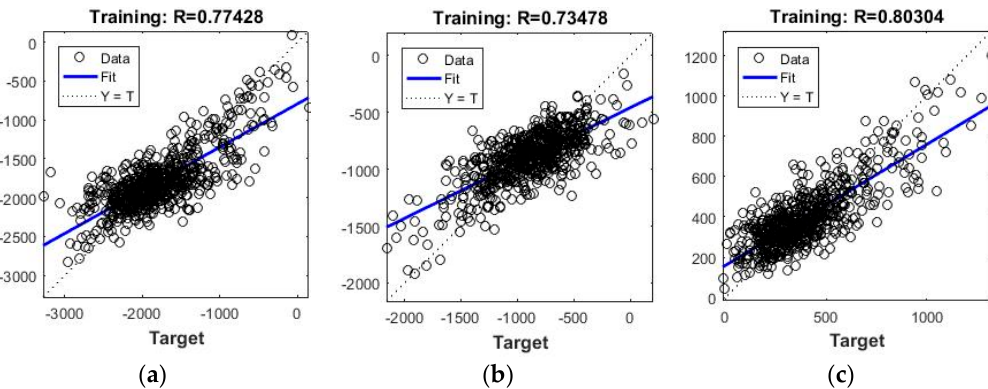
Figure 9. BNN 10 hidden layers fitting results based on the 85% of the samples: ( a ) Group of multispectral bands, multispectral and hyperspectral vegetation indices against GPR slice depth between 0.00–0.20 m; ( b ) Group of multispectral bands, multispectral and hyperspectral vegetation indices against GPR slice depth between 0.20–0.40 m; and ( c ) Group of multispectral bands, multispectral and hyperspectral vegetation indices against GPR slice depth between 0.40–0.60 m.